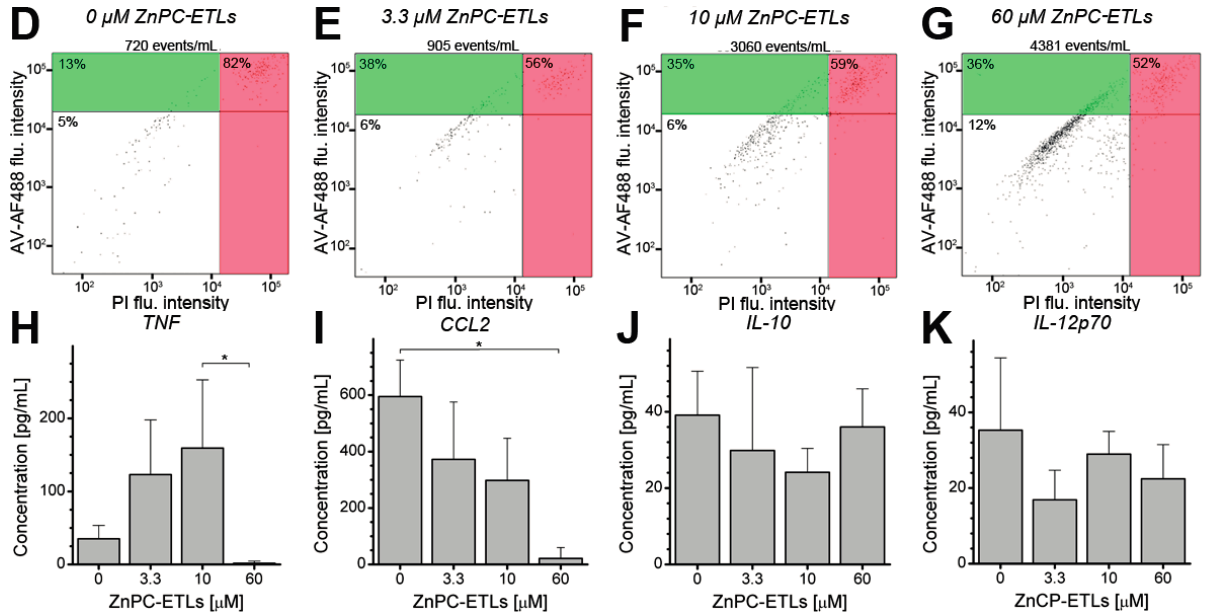
Figure 1. ( A ) Viability of EMT-6 cells as determined 24 h after photodynamic therapy (PDT) with zinc phthalocyanine-encapsulating endothelium-targeted liposomes (ZnPC-ETLs) at the indicated concentrations. Cells were placed in hypoxic conditions immediately following PDT (mean ± SD, N = 6). Data were analyzed using a one-way ANOVA and Sidak’s post-hoc test. Significant differences versus the corresponding control group are indicated with a pound sign, whereas are indicated with asterisks. The number of signs indicates the level of significance: * p < 0.05, **** p < 0.001 for intergroup differences, #### p < 0.001 versus control; ( B ) Flow cytometry-based characterization of the mode of EMT-6 cell death 24 h after PDT and subsequent incubation under hypoxic conditions (mean ± SD, N = 3). Staining was performed with Alexa Fluor 488-conjugated annexin V (apoptosis) and propidium iodide (necrosis); ( C ) The medium from EMT-6 cells was harvested 24 h after PDT and subsequent hypoxic incubation, and added to cultured RAW 264.7 macrophages. After 24 h of stimulation, macrophage activation was assessed by measuring nitric oxide (NO) production, which is a measure of macrophage activation. Cells were stimulated with 1 μ g/mL lipopolysaccharide (LPS) for 24 h as positive control. The number behind “PDT” refers to the final lipid concentration of ZnPC-ETLs; ( D – G ) The medium from PDT-treated EMT-6 cells was analyzed for healthy, apoptotic (green), and necrotic (red) cells by flow cytometry; ( H – K ) Cytokine release by PDT-treated EMT-6 cells was assayed 24 h after PDT and subsequent hypoxic incubation (mean ± SD, N = 3). The “0 μ M ZnPC-ETLs” group was not irradiated and served as negative control. Data were analyzed using a Kruskal–Wallis test and Dunn’s post-hoc test for multiple comparisons. The ZnPC-ETL concentrations ( x -axes) refer to final lipid concentration. The ZnPC:lipid molar ratio was 0.003 [6]. * p <